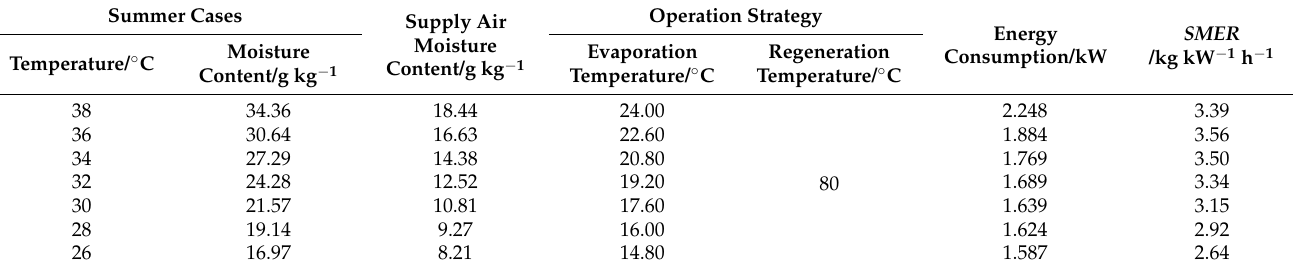
Table 5. Low-energy operation strategy of HDS in summer